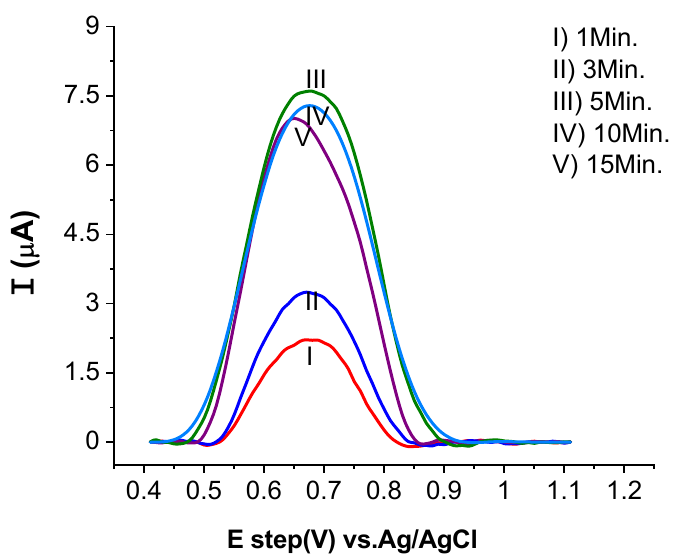
Figure 8. Effect of the accumulation time on SWV curves of 250 μM CR in 0.1 M ABS at pH 6.5.